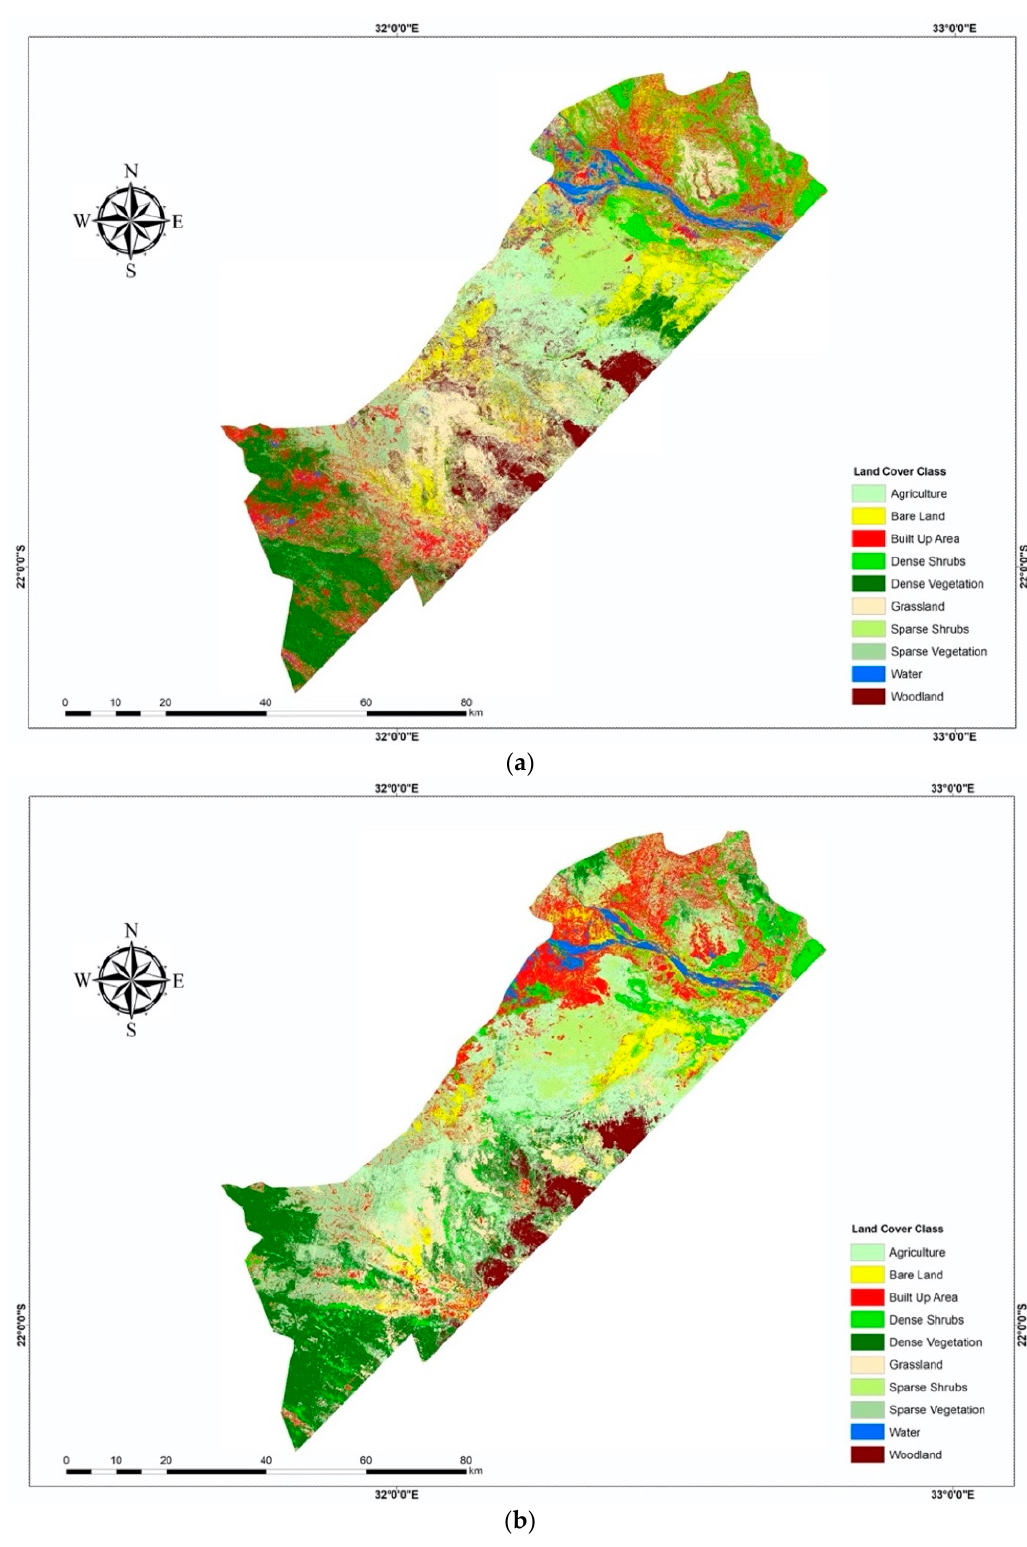
Figure 3. Landscape change in Gonarezhou ( a ) 2007 and ( b ) 2017 [41].